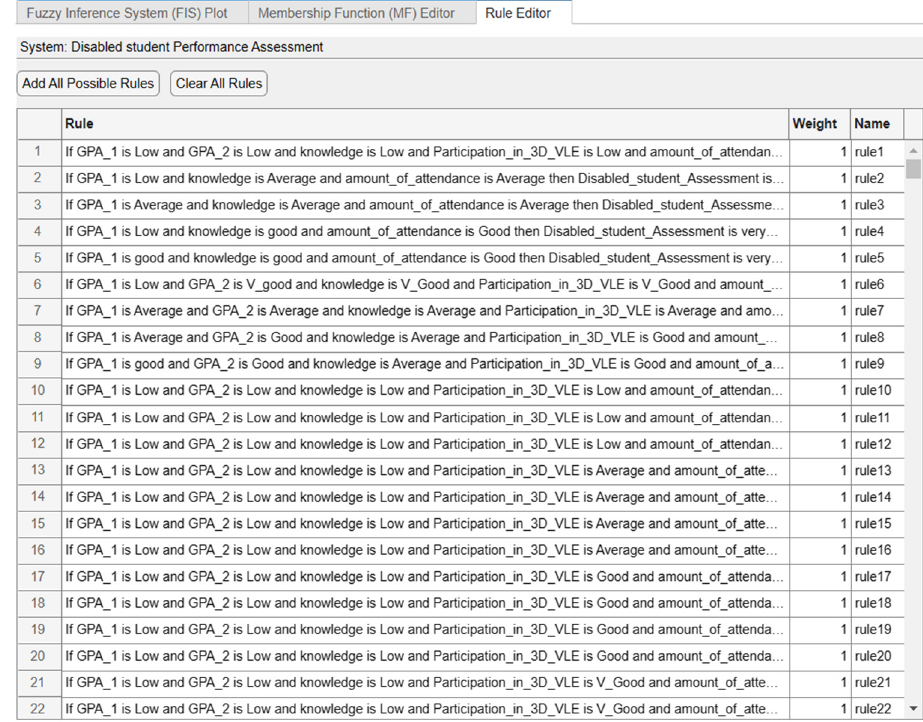
Figure 8. A rule-based fuzzy logic system.